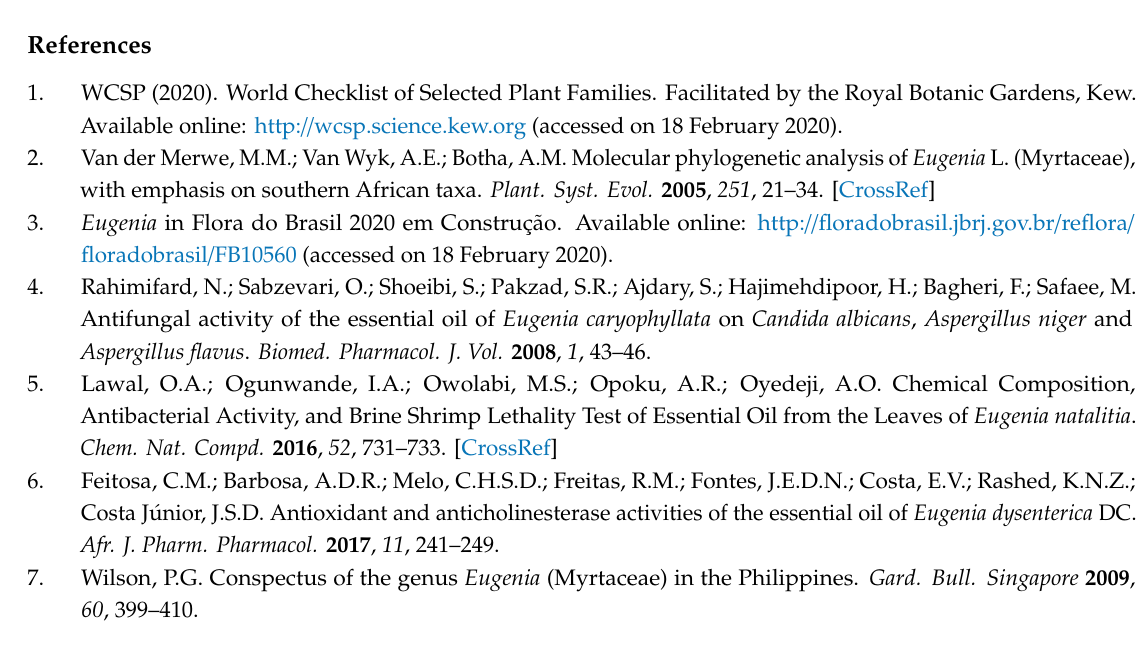
Table S1: Mass spectra and retention index of the main compound identified in the essential oils of Eugenia uniflora